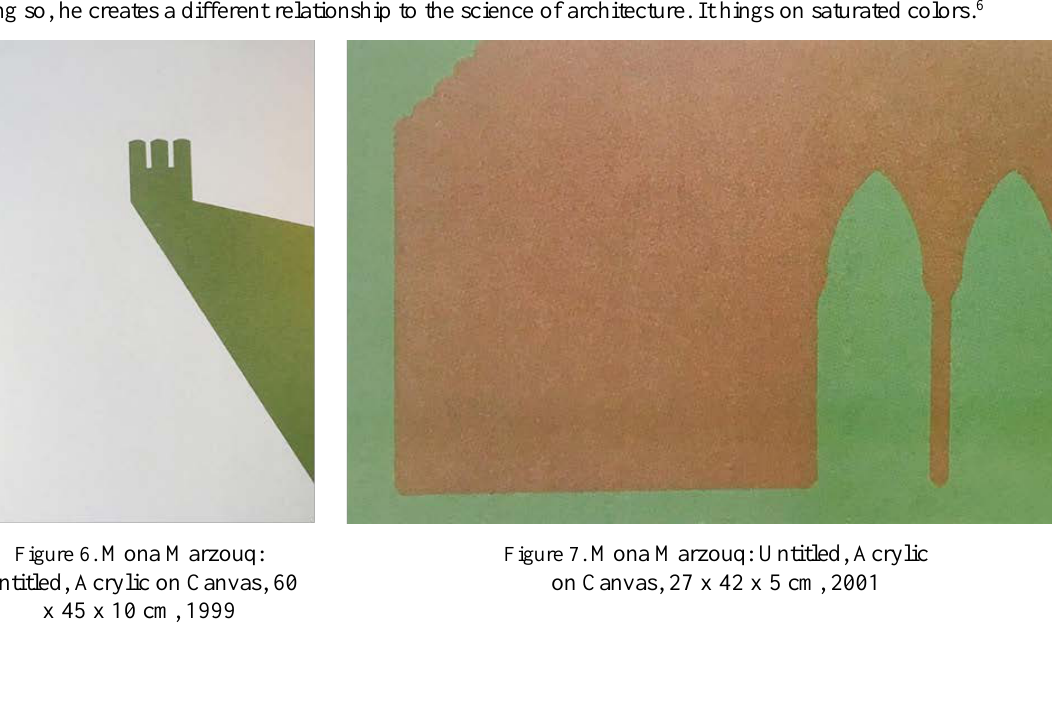
Figure 7. Mona Marzouq: Untitled, Acrylic on Canvas, 27 x 42 x 5 cm,